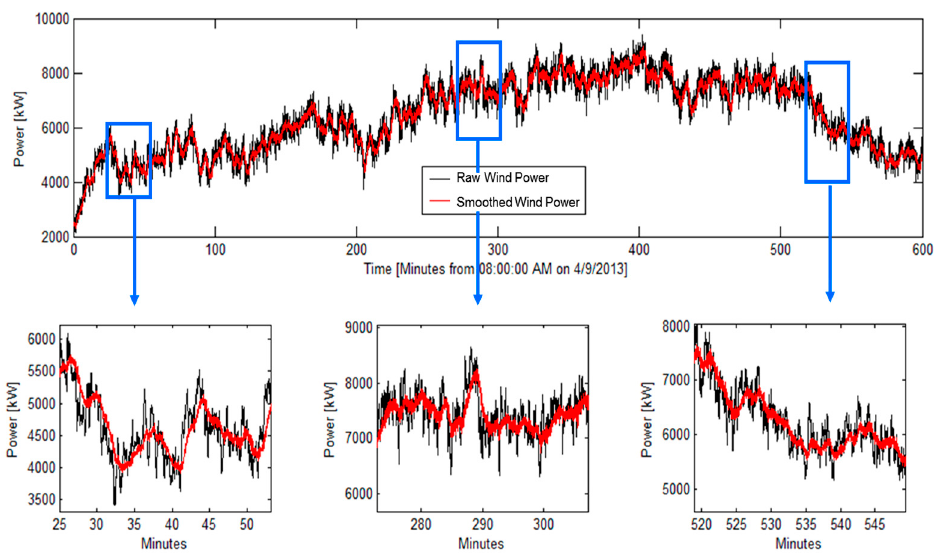
Figure 12. Time series of power output from the HRD wind farm (black) and the smoothed power (red) for the morning of 4/4/2013. The bottom three plots show the sections indicated by the blue boxes in greater detail.